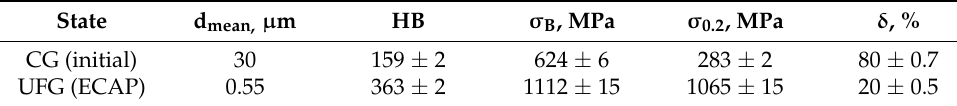
Table 2. Mean grain size and tensile mechanical properties of the steel.